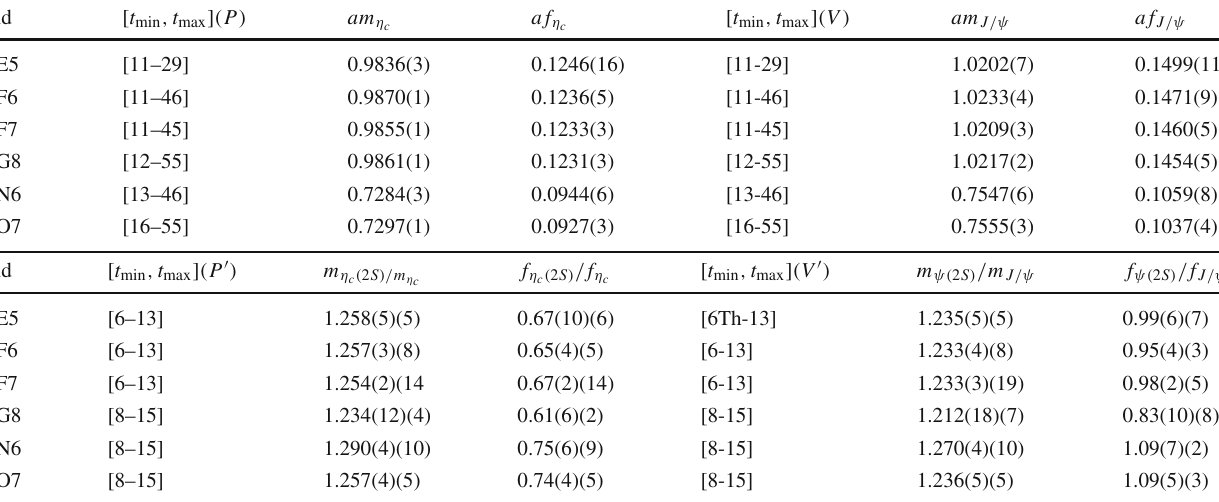
Table 3 Masses and decays constants of η c , η c ( 2 S ) , J /ψ and ψ( 2 S ) , in lattice units, extracted on each CLS ensemble used in our